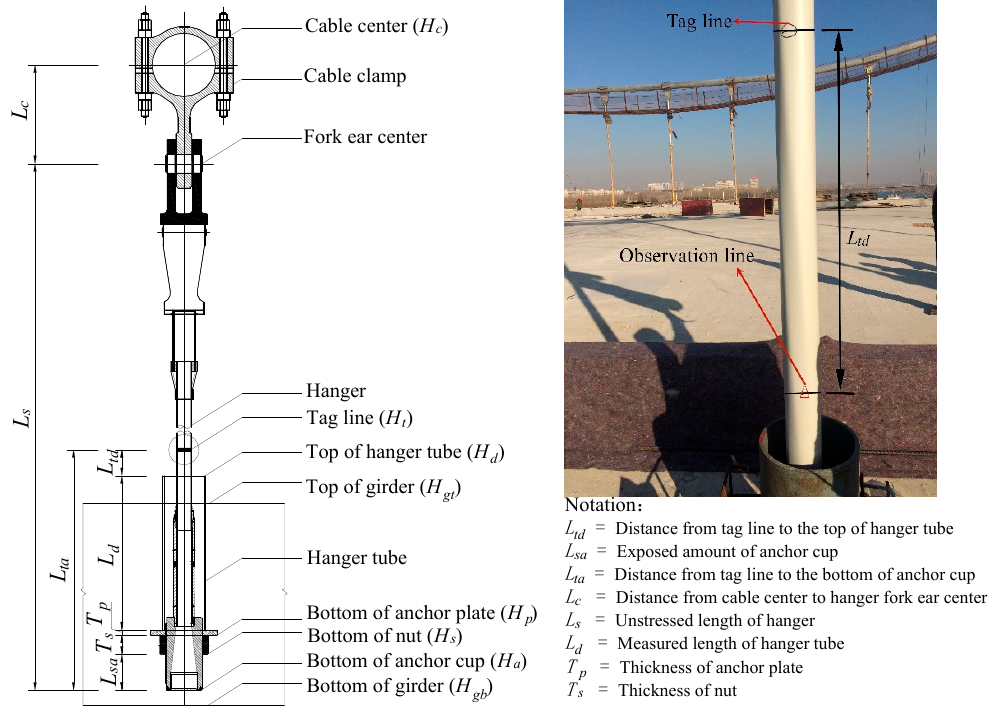
Figure 17. Calculation schematic and photo of the multiple-control method for system transformation. The target distance L tdij from the tag line to the top of the hanger tube was calculated based on the vertical displacement ∆ H gij of the girder caused by hanger tensioning, as well as the target value of the exposed amount L saij of the hanger anchor